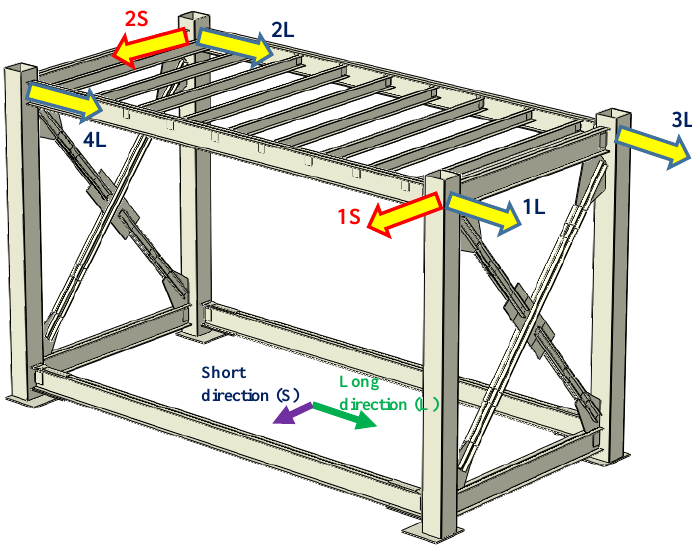
Figure 7. Position and orientation of accelerometers, along with the naming convention. Module plan. L: long direction; S: short braced direction.